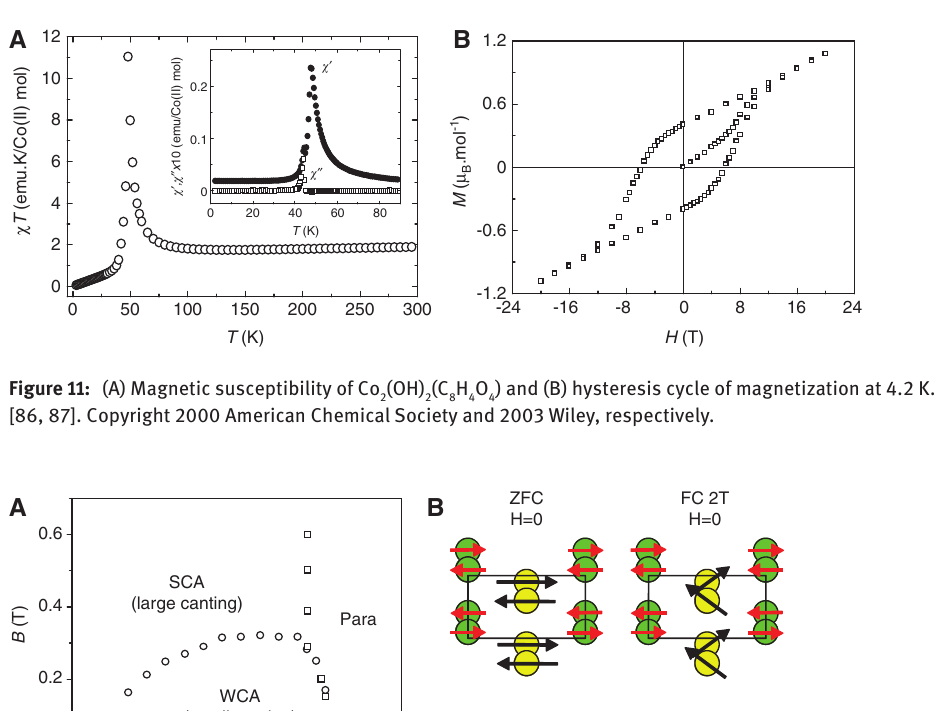
Figure 12: (A) Magnetic phase diagram of Co cooling with zero field (left) and cooling under 20 kOe. The view, along a, shows two adjacent Co planes, at x = 0 and x = ½, whose moments are aligned in the AF ZFC case. Adapted with permission from [116]. Copyright 2003